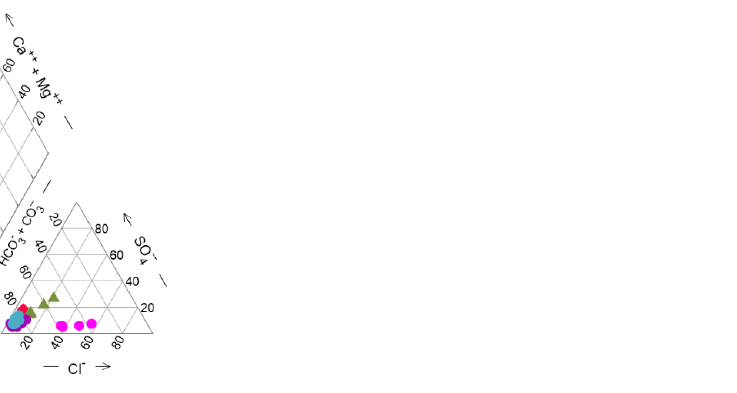
Figure 2. Piper diagram of sampled waters. Blue circles—GW deep; Violet circles—GW shallow; Pink circles—GW shallow water from P ‐ 4039; Red diamonds—SW; Green triangles—gravel pit.